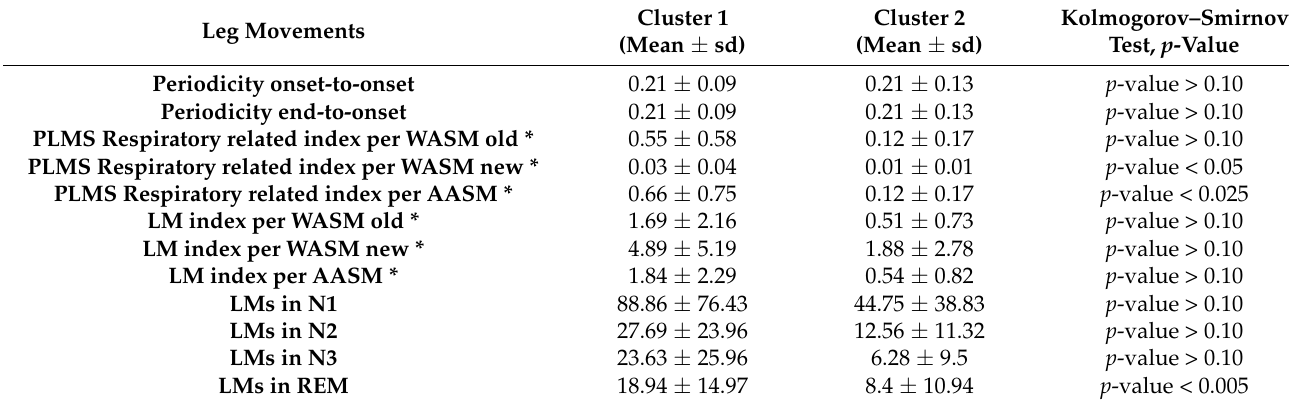
Table 5. Leg movement scoring between the two clusters.